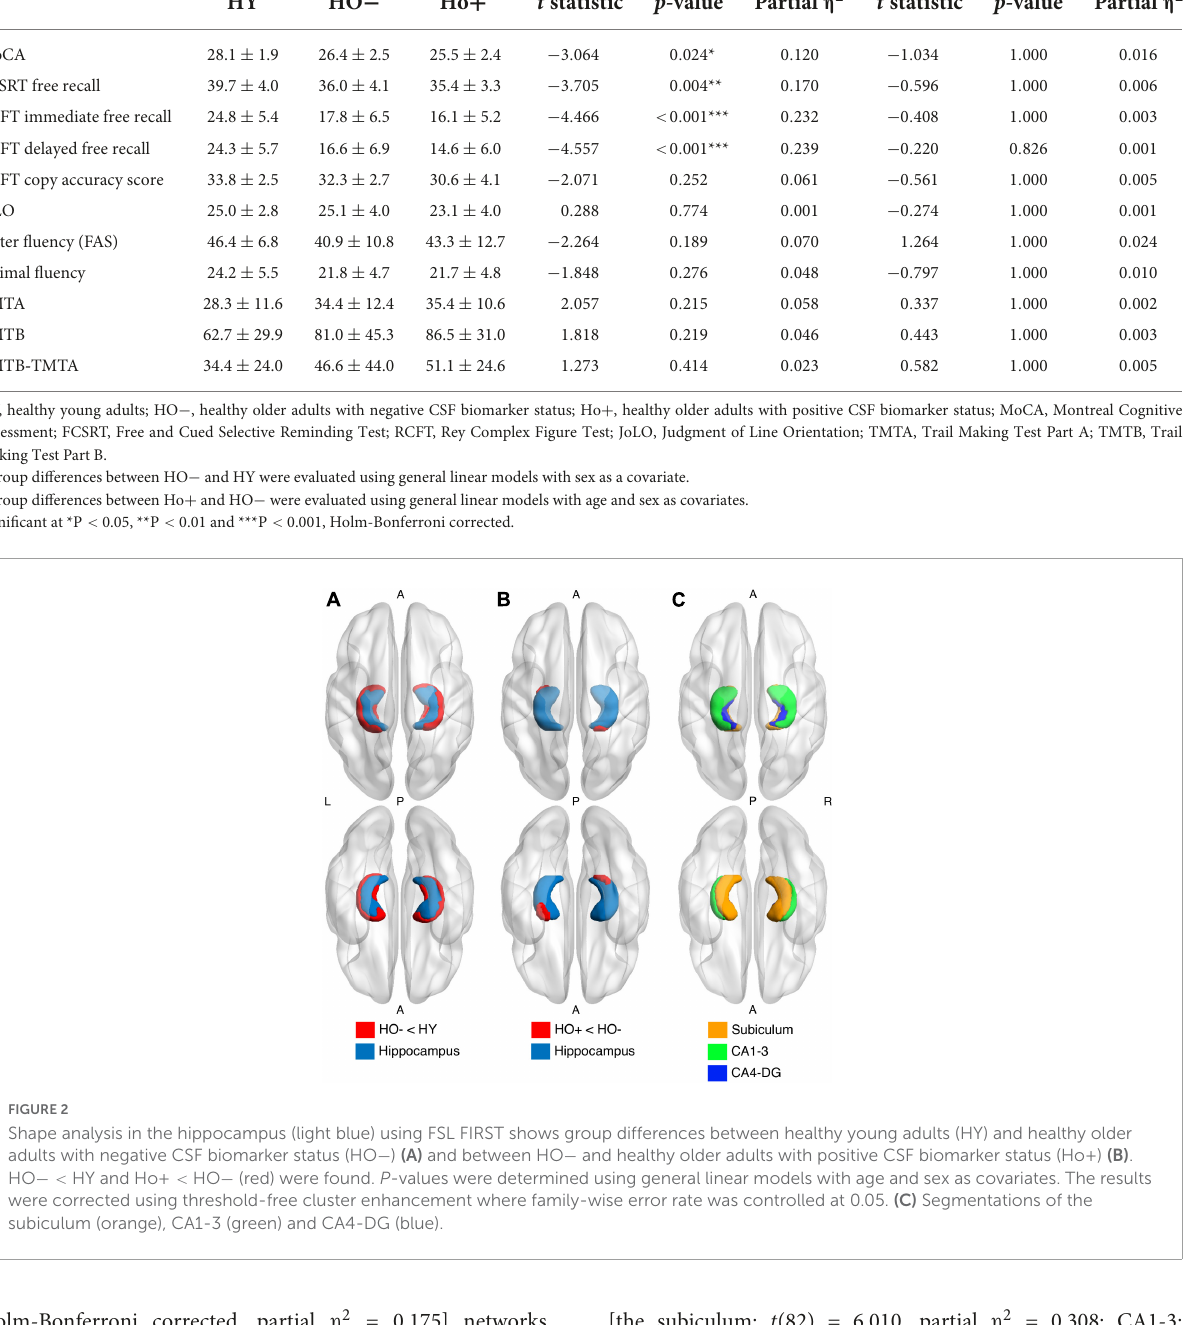
hippocampal subfields (all P < 0.001, Holm-Bonferroni corrected) as compared to